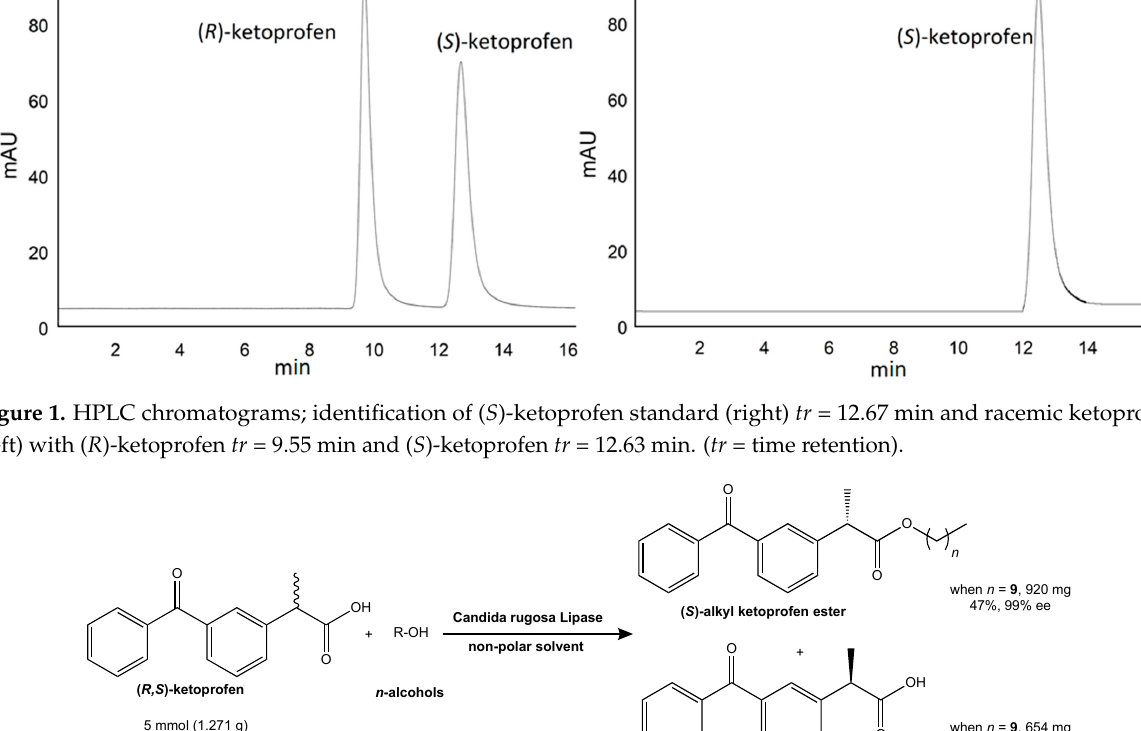
into ( S )-decyl ketoprofen ester using Candida rugosa lipase, Candida antarctica lipase type B (Novozym 435), Mucor javanicus lipase, and porcine pancreatic lipase as biocatalysts. Candida antarctica lipase (CAL) was quicky discarded due to its very low activity in both conversion ( c ) and enantioselective (ee) during the esterification attempts (data not shown). However, using Candida rugosa lipase (CRL) and adopting our previously re- Scheme 1. Enantioselective enzymatic ketoprofen esterification reaction. (Lipases from: Candida rugosa , Candida antarctica , Mucor javanicus and porcine pancreas, temperatures of 30, 40, and 50 ◦ C, solvents: hexane, cyclohexane, and isooctane; alcohols: methanol, n -butanol, n -octanol, and n